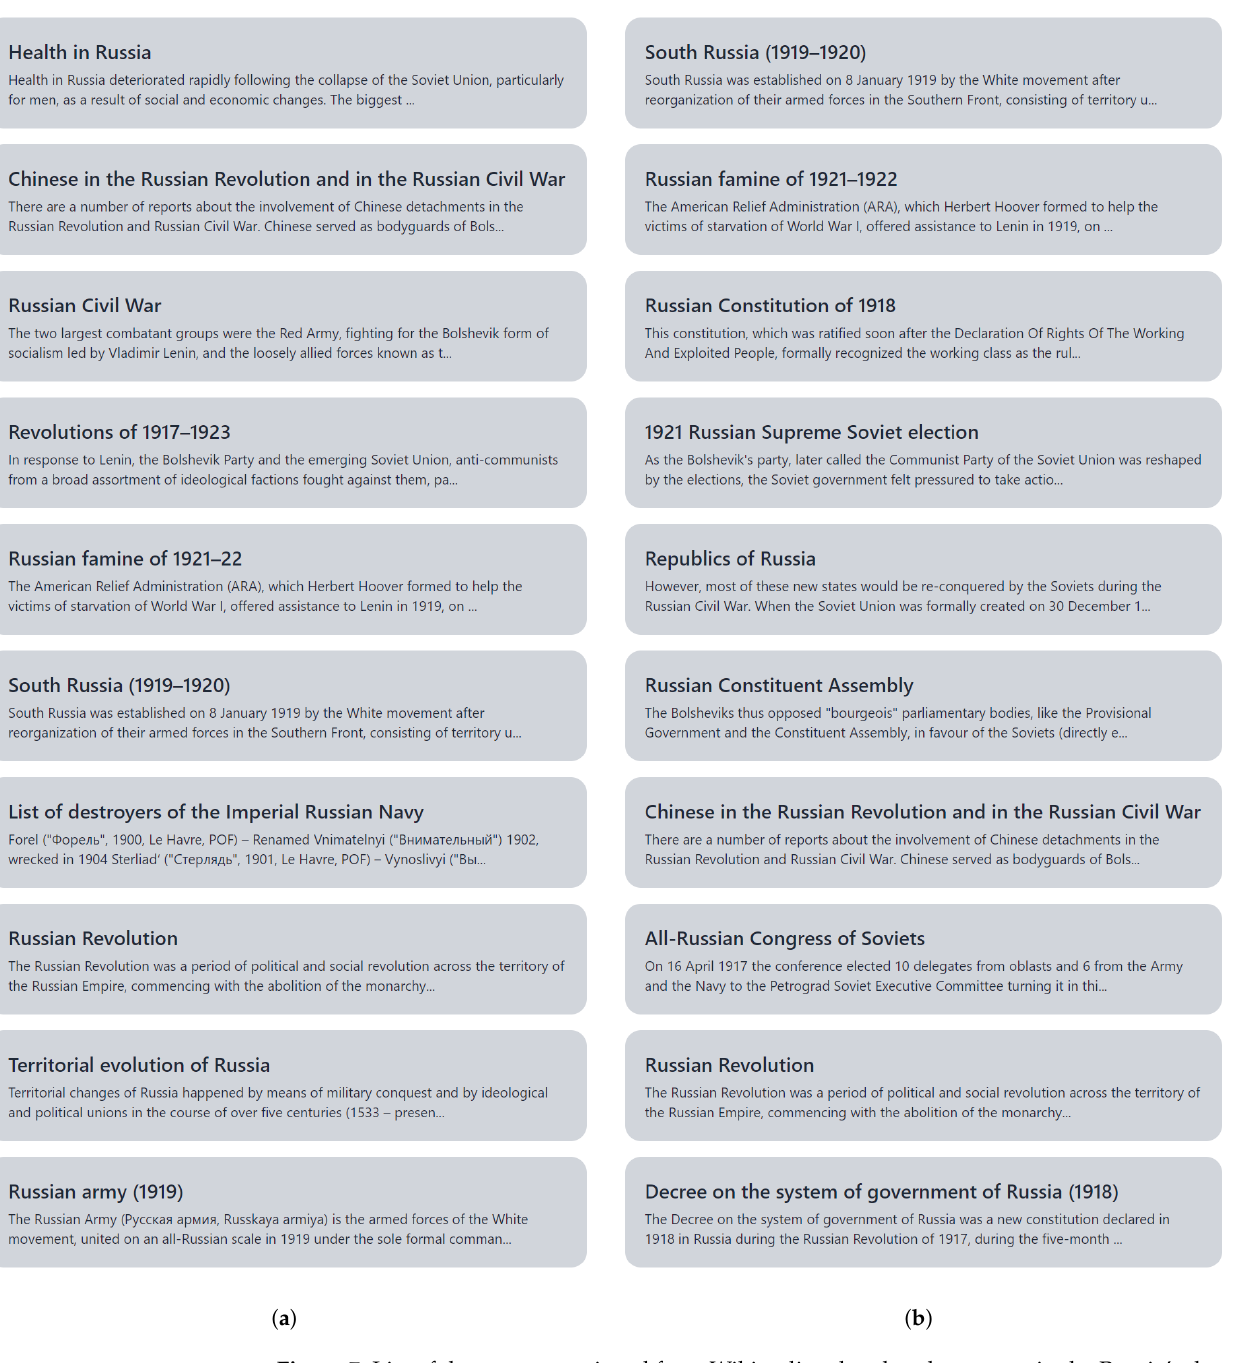
Figure 7. List of documents retrieved from Wikipedia related to the pattern in the Russia’s dataset between 1917 and 1919, indicating several potential events that may have affected it. ( a ) Selection of the valley of Russia’s life expectancy. ( b ) Selection of the drop of Russia’s democracy index